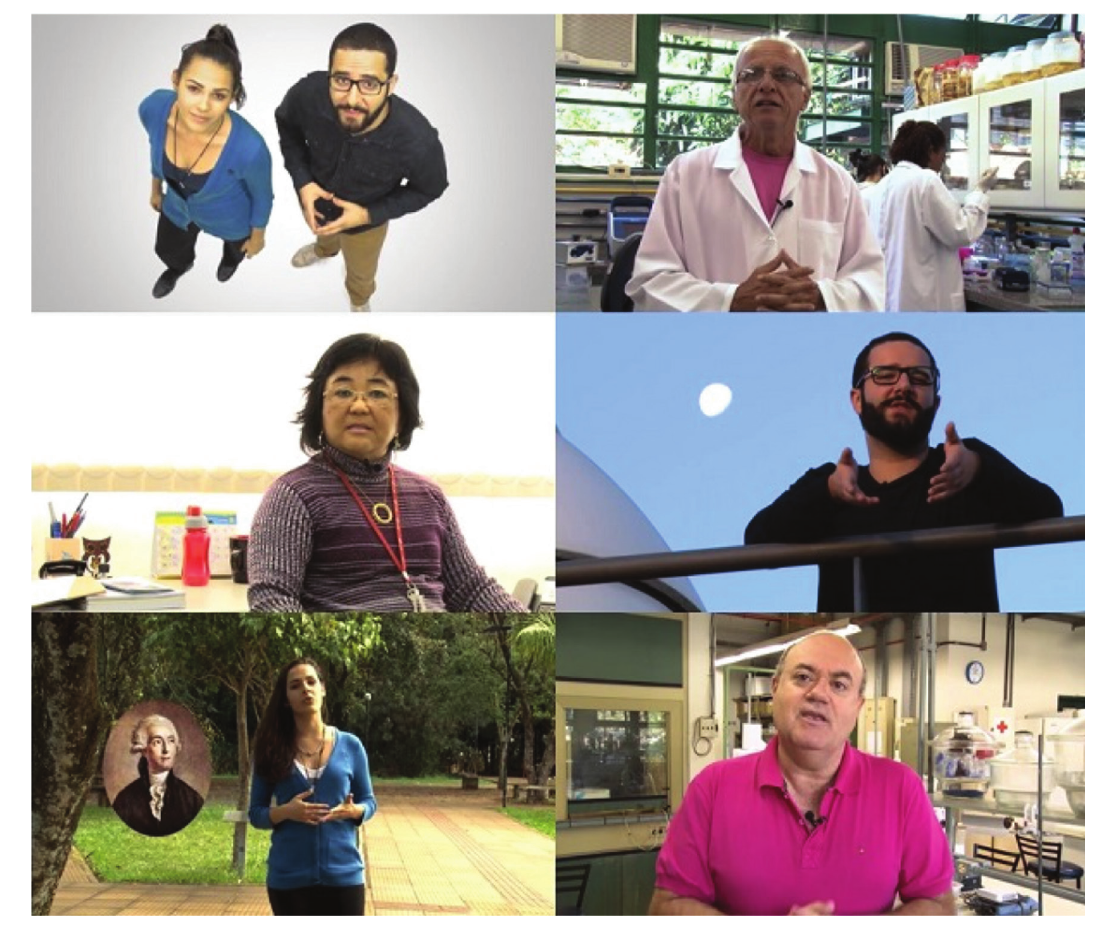
Figure 4. Images from some of the episodes of the Knowledge Paths series, its presenters in the studio and in some of the spaces where points of the museum are located, together with some of the scientists interviewed (Source: Authors,